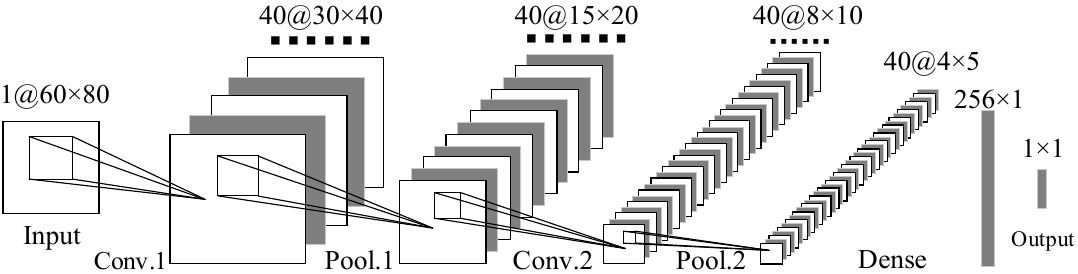
Figure 4. The architecture of deep convolutional neural networks (CNNs).